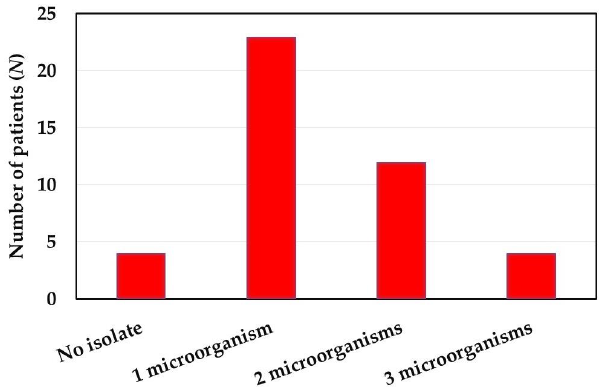
Figure 3. Number of microorganisms isolated from cataract patients preoperatively. Table 2. Di ff erent Microorganisms Isolated from Eyelid Margin of Cataract Patients Preoperatively. Isolated Microorganisms Number of